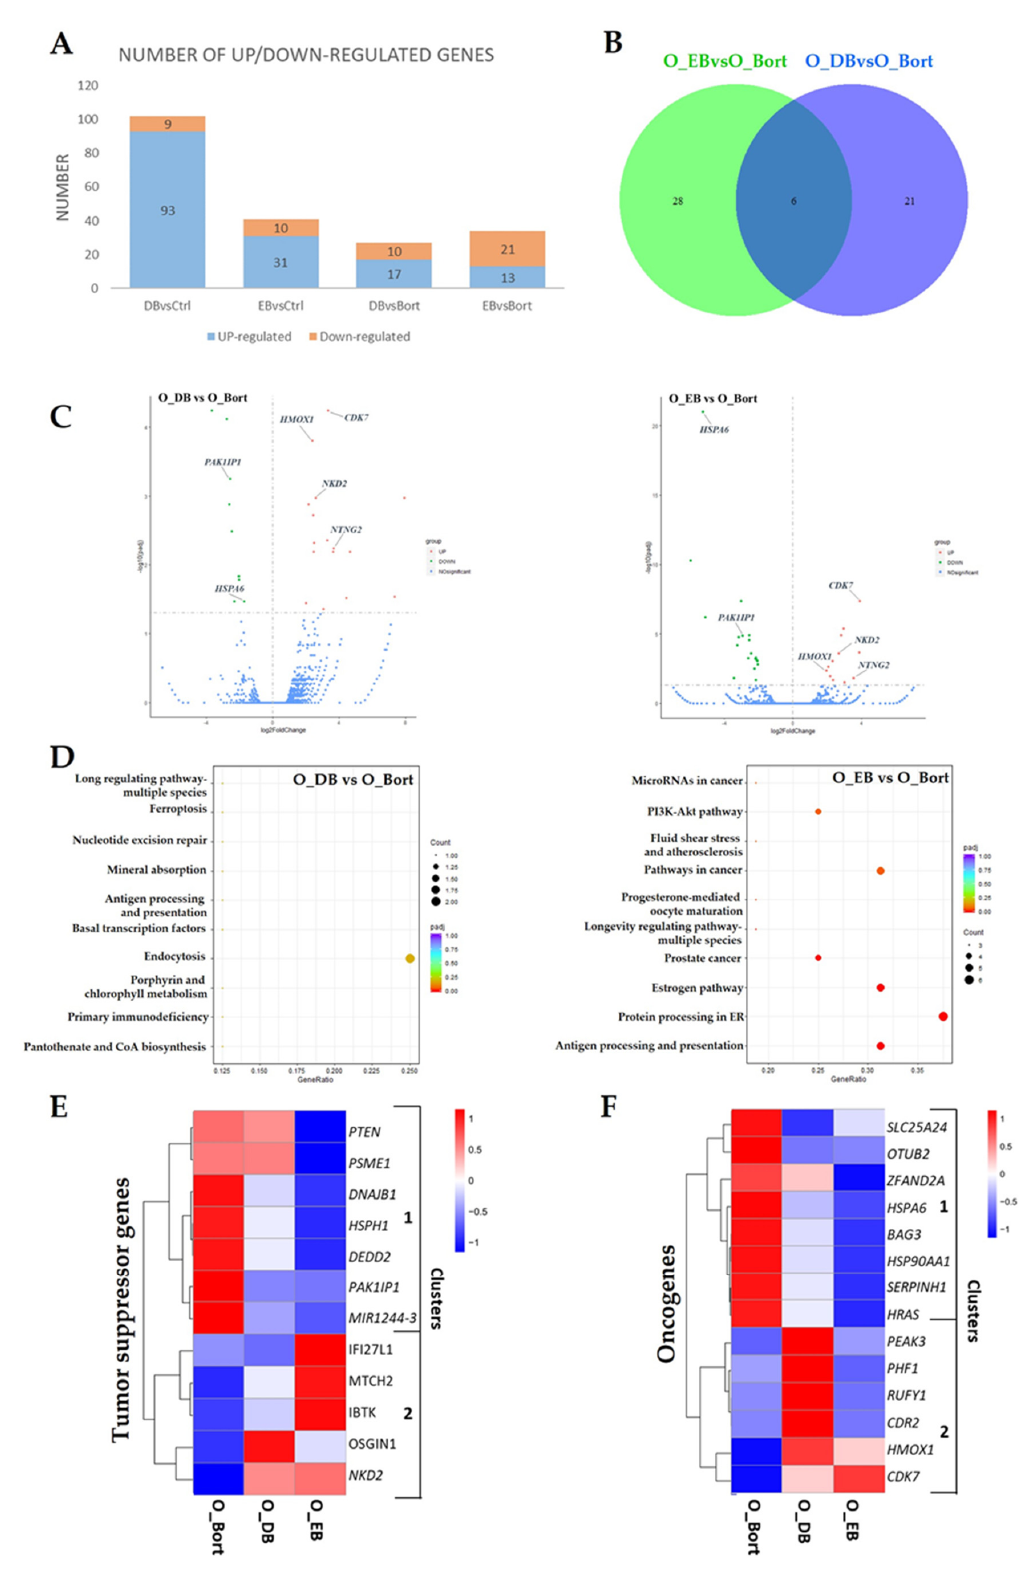
Figure 2. Simultaneous treatment with bortezomib and DHA or EPA altered tumor-associated gene expression in the OPM2 cell line. Cells were treated with 10 nM of bortezomib for 4 h in the presence of DHA/EPA (50 µ M), and then RNA-seq